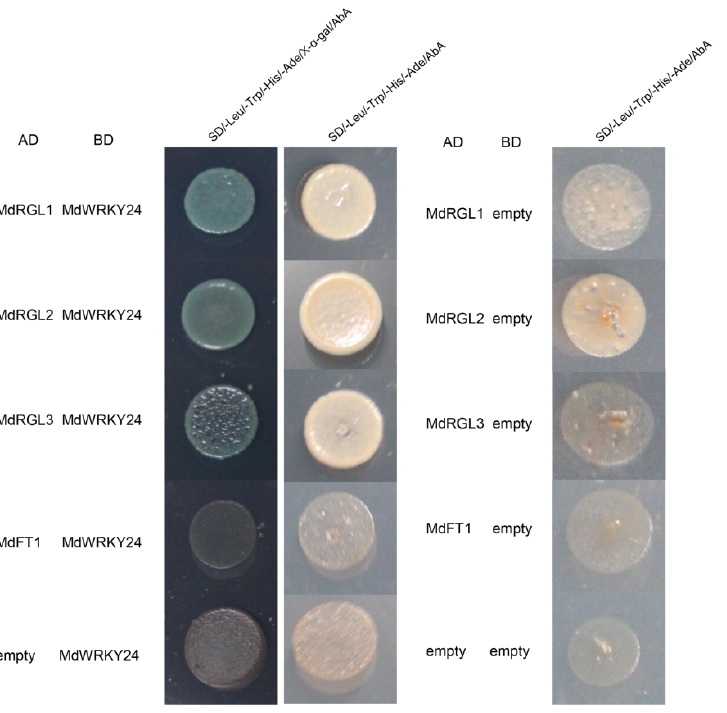
Figure 9. Yeast two-hybrid analysis of the interaction between MdRGL1, MdRGL2, MdRGL3, MdFT1, and MdWRKY24.